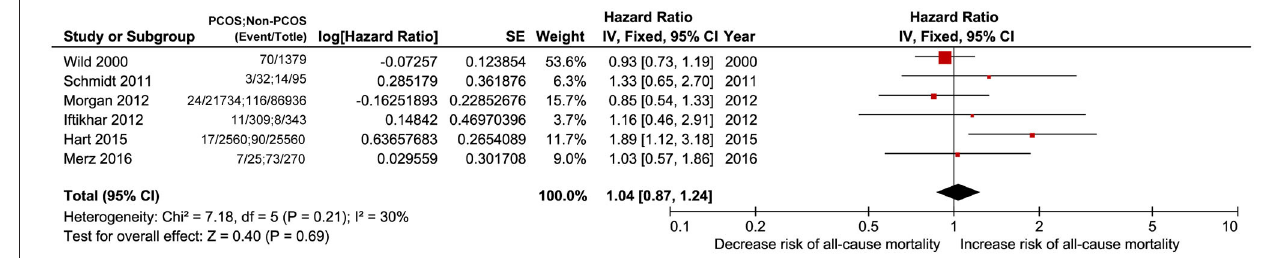
FIGURE 2 | Forest plot comparing PCOS and non-PCOS for all-cause mortality.